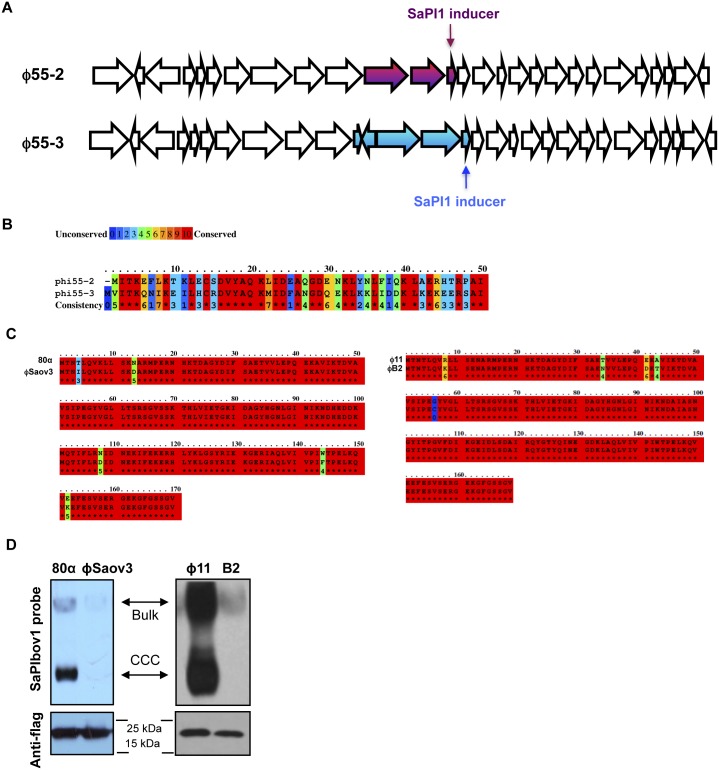
Coevolved SaPIs block phage reproduction.Plates carrying the SaPI-negative RN4220 strain, RN4220 derivatives carrying the original SaPIbov1 or SaPIbov2 islands, or RN4220 derivatives carrying evolved SaPIbov1 or SaPIbov2 islands were infected (<700 p.f.u. per plate) with two different evolved phage 80α. Genotype of the SaPIbov1 evolved island: A deleted from position 14119; genotype of the SaPIbov2 evolved island: deletion affecting residues from N122 to K168. Phage 1: 80α Dut I75N, ORF15 Q3*, Δsri; Phage 2: Dut S63I, ORF15 A38E, sri G 10983 A.